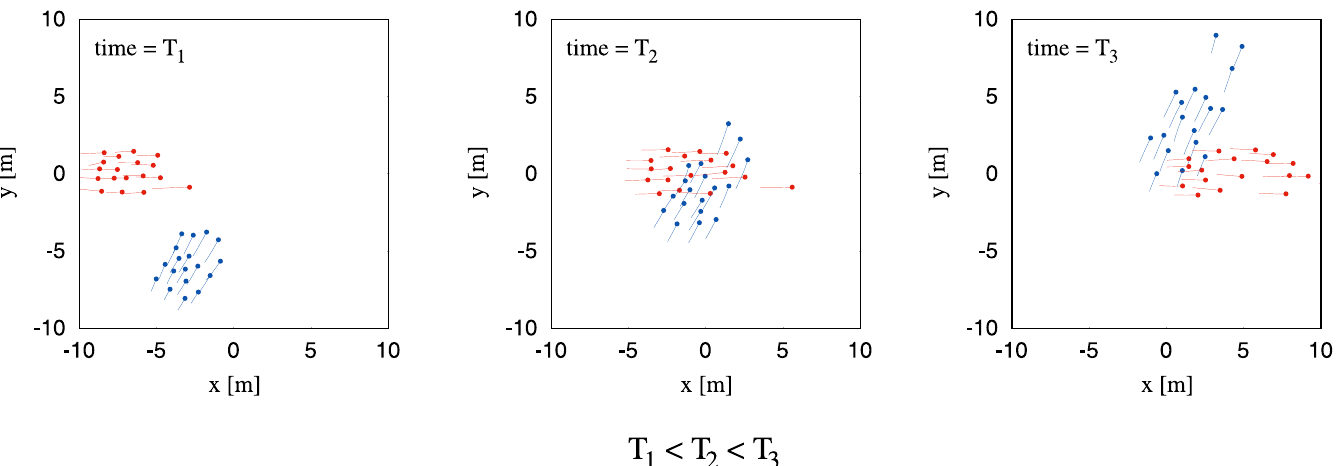
Fig 2. Illustration of a trial of crossing flow from our experiments. Traces of all the pedestrians involved for a typical trial has been shown with expected value of crossing angle equal to 60˚. Three different instances of the trial has been shown here viz. before crossing ( T 1 ), during crossing ( T 2 ) and after crossing ( T 3 ). The actual values of time frames are T 1 = 2.3 sec, T 2 = 6.55 sec and T 3 = 10.8 sec from the beginning of the trial. The two groups of pedestrians are denoted by blue and red dots. The tails behind each of the dots are basically the distances travelled by the pedestrians in previous 1.25